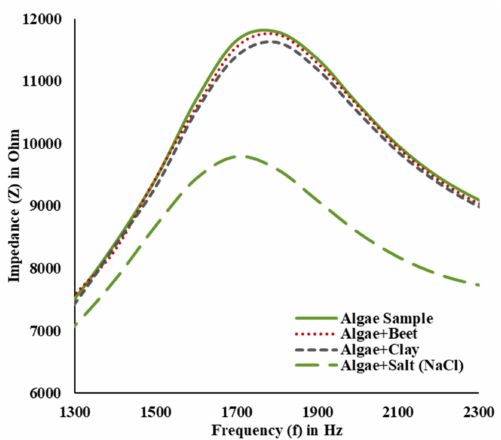
Figure 10. Robustness of the EIS sensor selectivity method in the presence of other ingredients in the